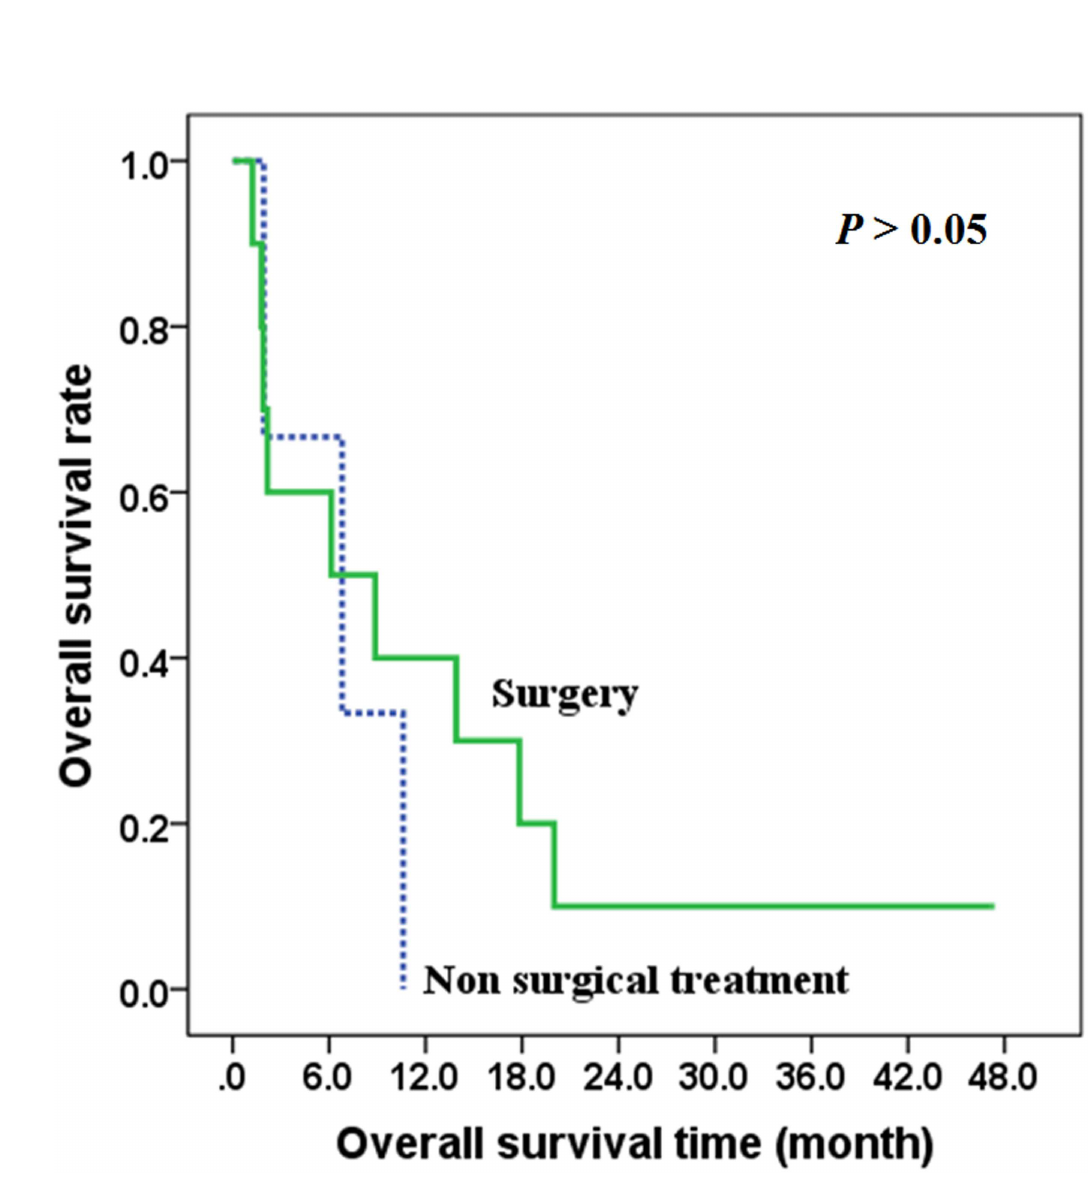
Fig 5. The effects of surgery on overall survival of stage IVC